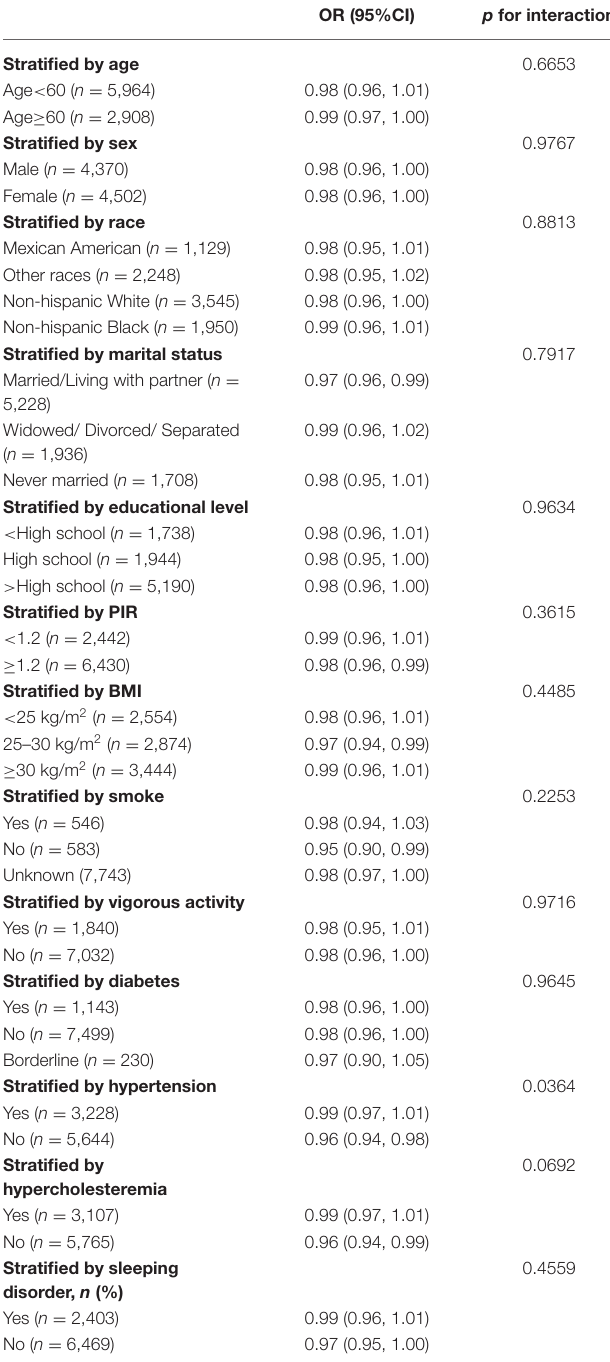
TABLE 4 | Subgroup analysis of association between fiber intake and nonfatal cardiovascular/cerebrovascular events. OR (95%CI) p for